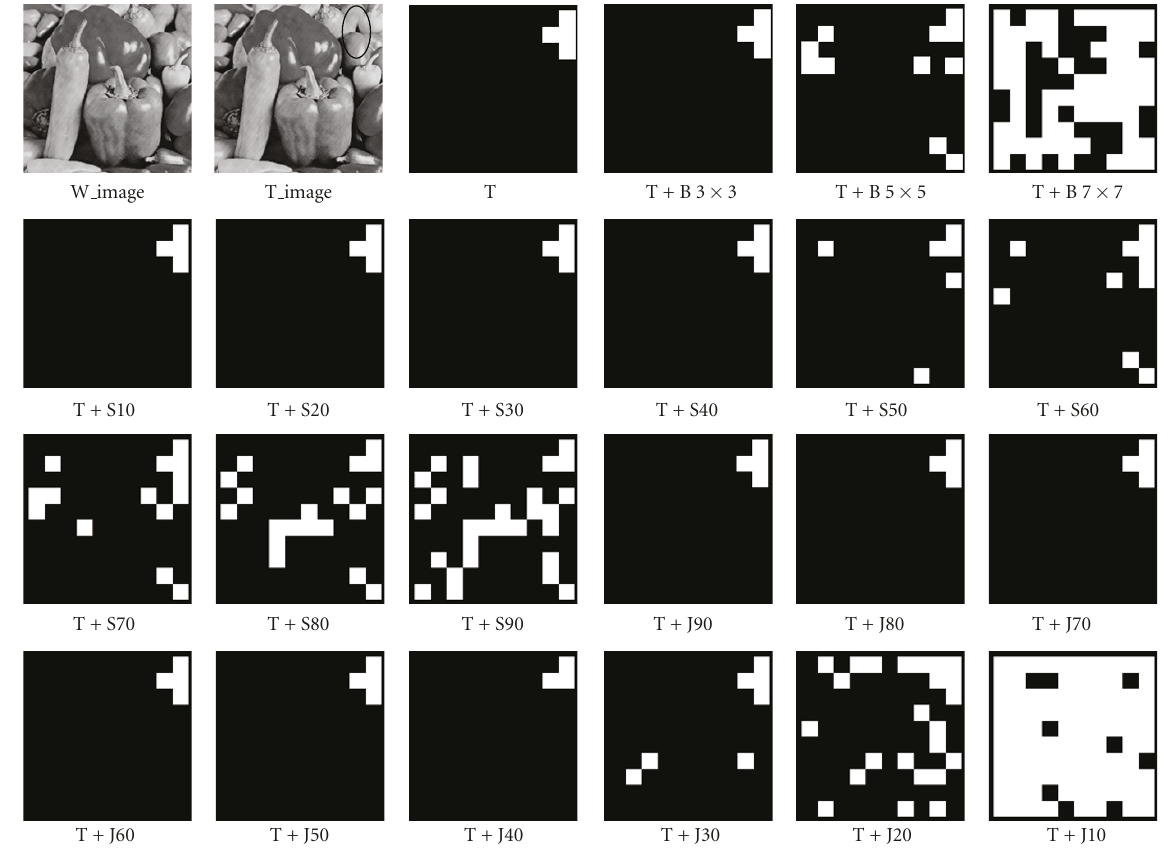
Figure 13: The detection results when combined attacks are applied to watermarked image. W image and T image denote the watermarked image and the tampered watermarked image, respectively. The oval in T image highlights the tampered part. The symbols T, J, B and S denote malicious tampering, JPEG-compression, blurring and sharpening, respectively. + means followed by. The number following each symbol is the parameter adopted by the manipulation in Photoshop. Table 4: Authentication results when JPEG compressions are applied to the corresponding watermarked images. regards the manipulation is incidental and × means that our scheme regards the manipulation is